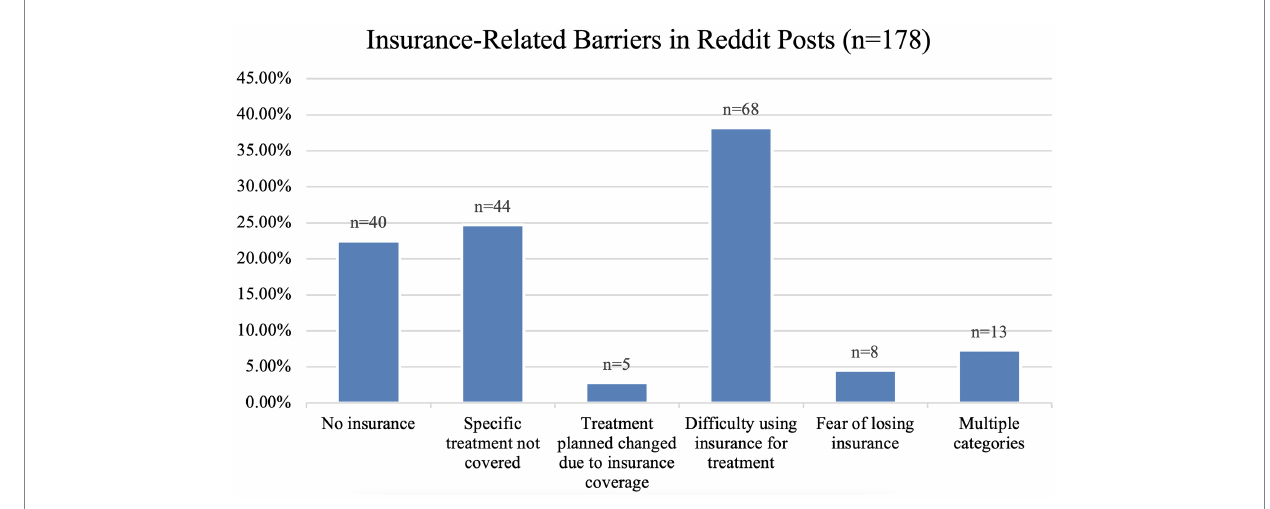
FIGURE 1 Breakdown of Insurance Related Barriers found in Reddit Posts.